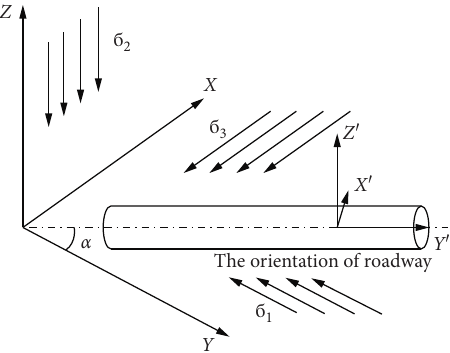
Figure 4: Actual triaxial stress state of the tunnel.